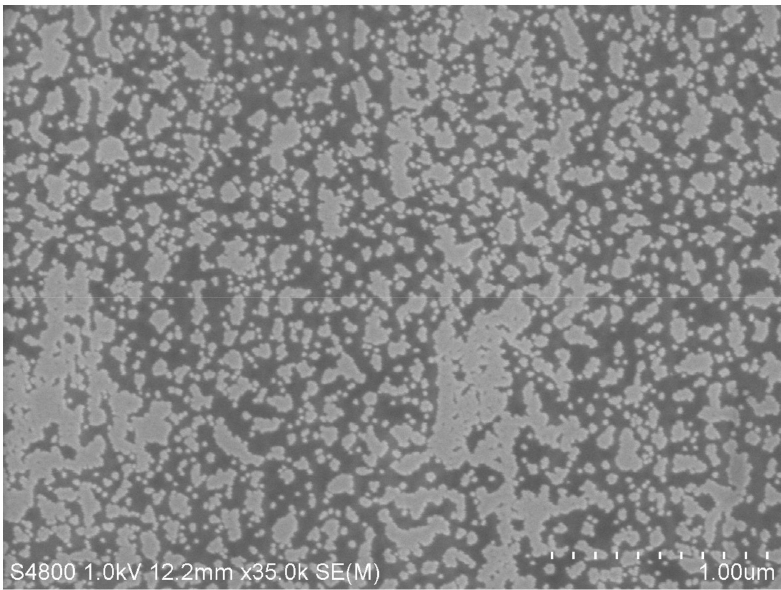
Figure 1. SEM image of the direct Al 2 O 3 ALD on CVD